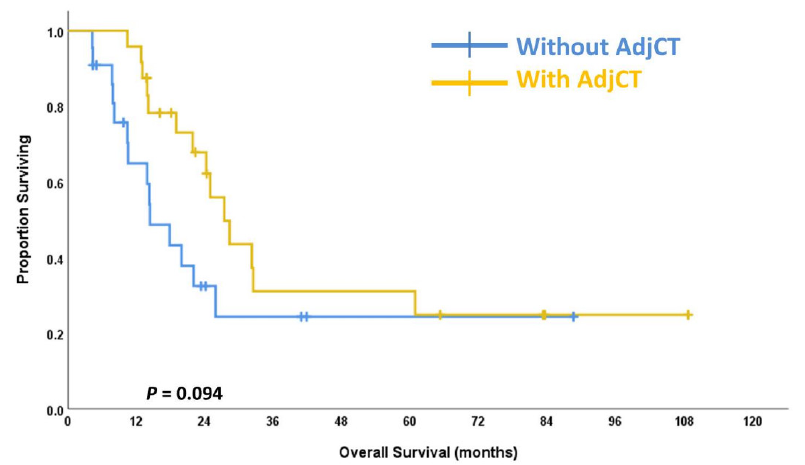
Figure 3. The overall survival curves for pathologic positive-node disease patients who received adjuvant chemotherapy (AdjCT) and patients who did not receive adjuvant chemotherapy (AdjCT).